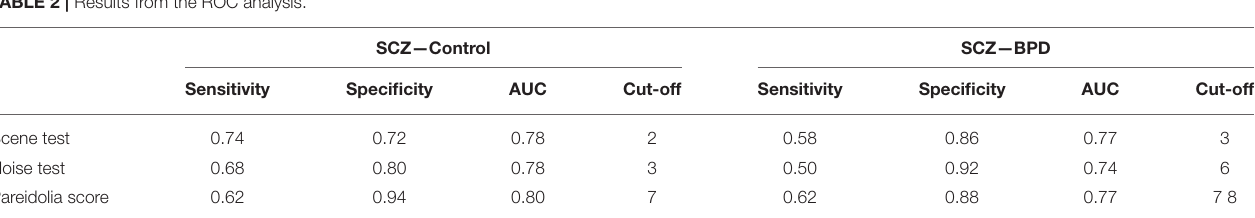
TABLE 2 | Results from the ROC analysis. SCZ—Control SCZ—BPD Sensitivity Specificity AUC Cut-off Sensitivity Specificity AUC